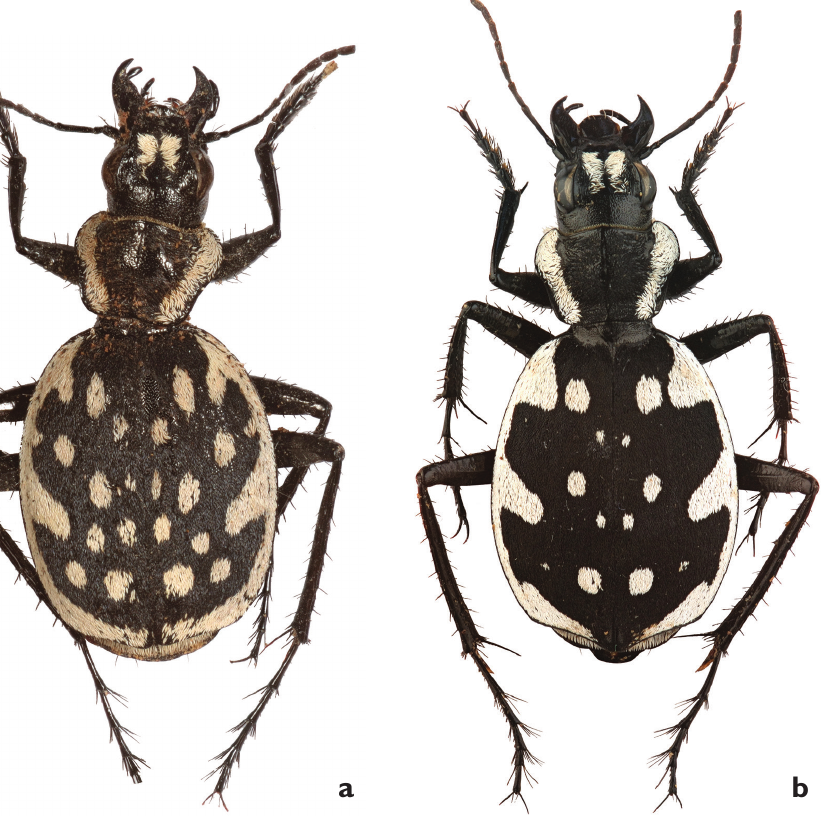
a b Figure 26. Dorsal habitus of Graphipterus : a G. rotundatus b G. serrator. Elytra oval, relatively elongated, humeri rounded; EL: 8.1–12 mm, average 10.6 mm; EW: 6.5–9.1 mm, average 8.0 mm; EL/EW: 1.3. Lateral cross section convex. Dense black scales, disc not seen between scales (Fig. 6a). White lateral margin as wide as half antennomere I long and with four extensions; extension I triangular with rounded angels, much wider than lateral margin, but shorter than extensionII; the lat- ter one elongated, positioned at second third of elytra. Apical sinuation strongly sinu- ated, apex strongly protruded, forming almost a rectangular. White posterior margin evenly rounded, not becoming narrower towards the suture; gap at suture wider than lateral margin. Disc with (10–) 14 (–16) spots; anterior pair of spots rounded to slight- ly elongate, much smaller than extension I; anterior and posterior pair of spots round, larger than other spots; small additional spots located medially to extension II and lat- erally to posterior spots. Apical sinuation strongly developed, apex protruded, almost rectangular, only slightly rounded at most distant tip (Fig. 7a). Suture inconspicuous. Legs long; MTIL: 4.9-7.0 mm, average 6.3 mm; El/MTIL: 1.7. Metatibial second- ary spur dark. MTAL: 5.4-6.9 mm, average 6.0 mm; MTAL/MTIL: 0.72. Claws of hind legs brown at